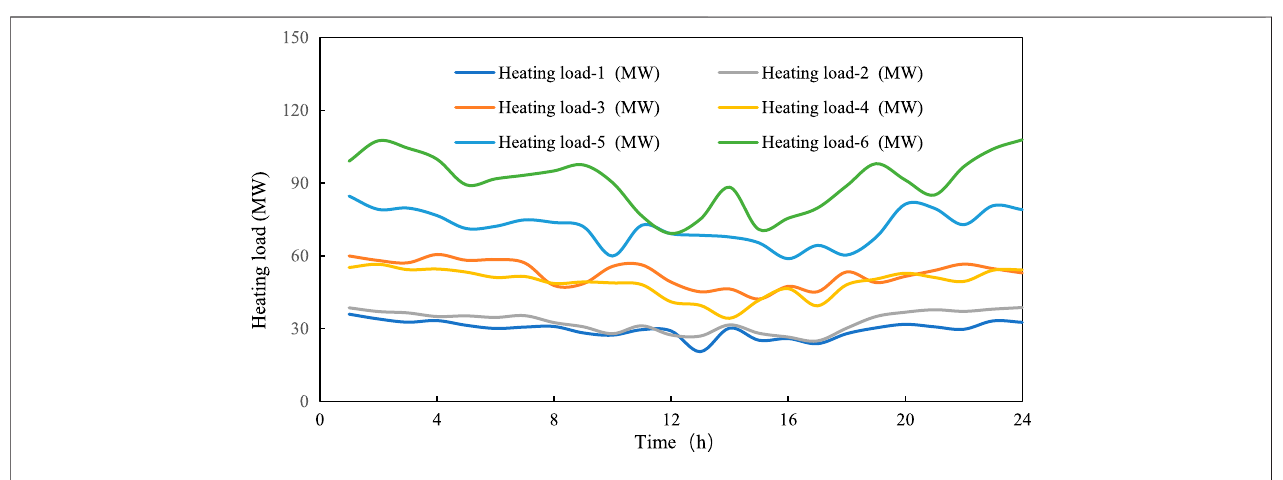
FIGURE 7 | Heat loads of different heating